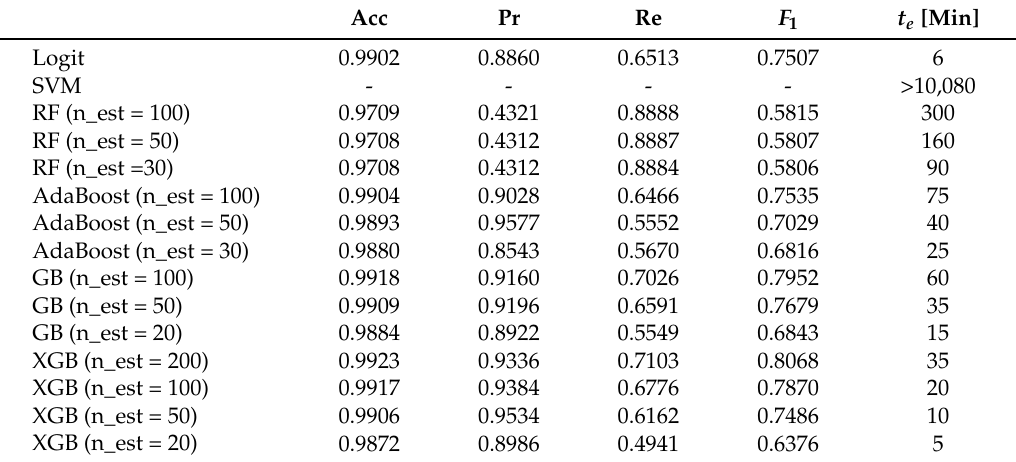
Table 2. Results acquired on real PPE images from the six classifiers: Logistic Regression (Logit), Support Vector Machine (SVM), Random Forest (RF), Adaptive Boosting (AdaBoost), Gradient Boosting (GB) and eXtreme Gradient Boosting (XGB). All these learners were evaluated on four parameters: Accuracy (Acc), Precision (Pr), Recall (Re) and F 1 score; moreover, the execution time was taken into account ( t e in